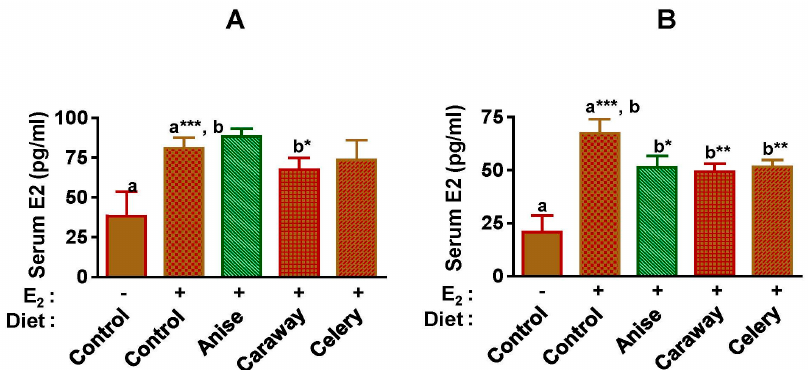
Figure 3. Circulating E2 levels measured at different time points in the blood plasma of the animals provided control AIN-93M diet or diet supplemented with spices (7.5% w / w ) euthanized after 3 ( A ) and 12 ( B ) weeks. Data represent mean ± SD ( n = 6). Symbols (– and +) denotes the absence and presence of E2, respectively. Alphabets (a and b) followed by asterisk shows statistical differences at * p < 0.05, ** p < 0.01, *** p < 0.001.